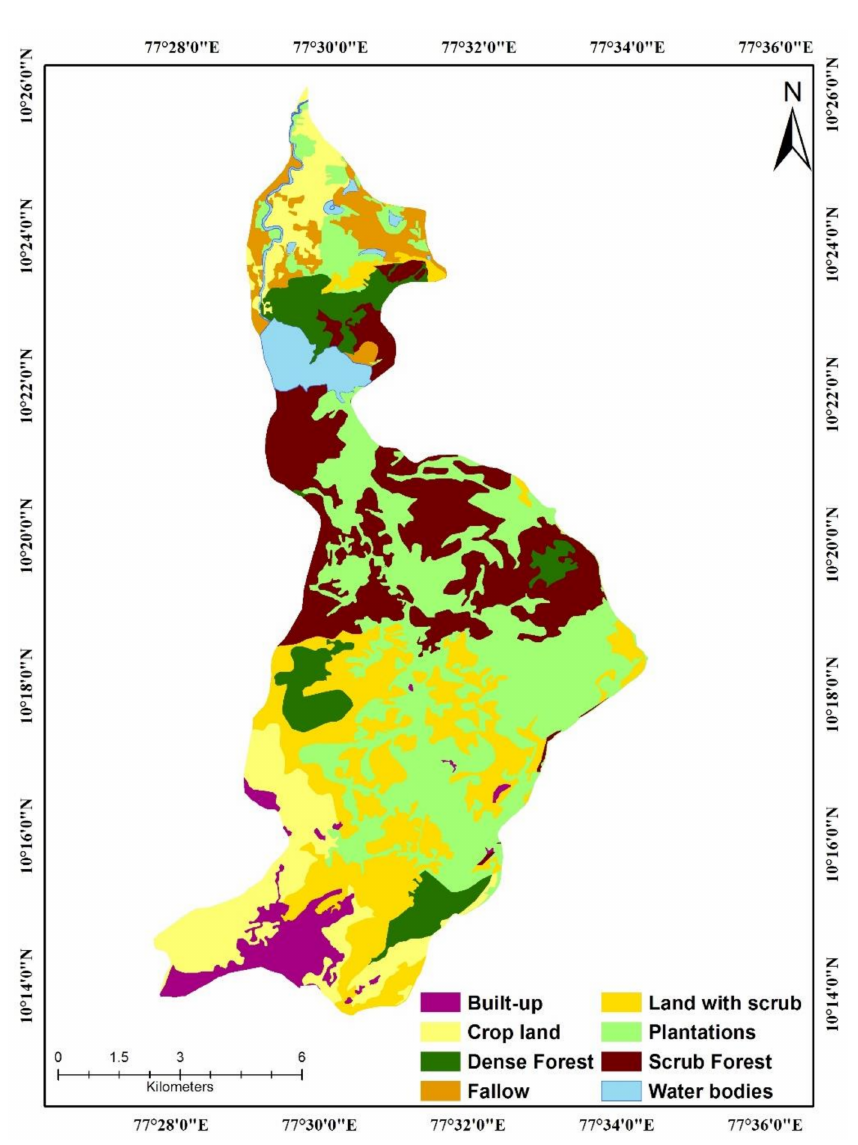
Figure 8. Land use and land cover distribution in Palar